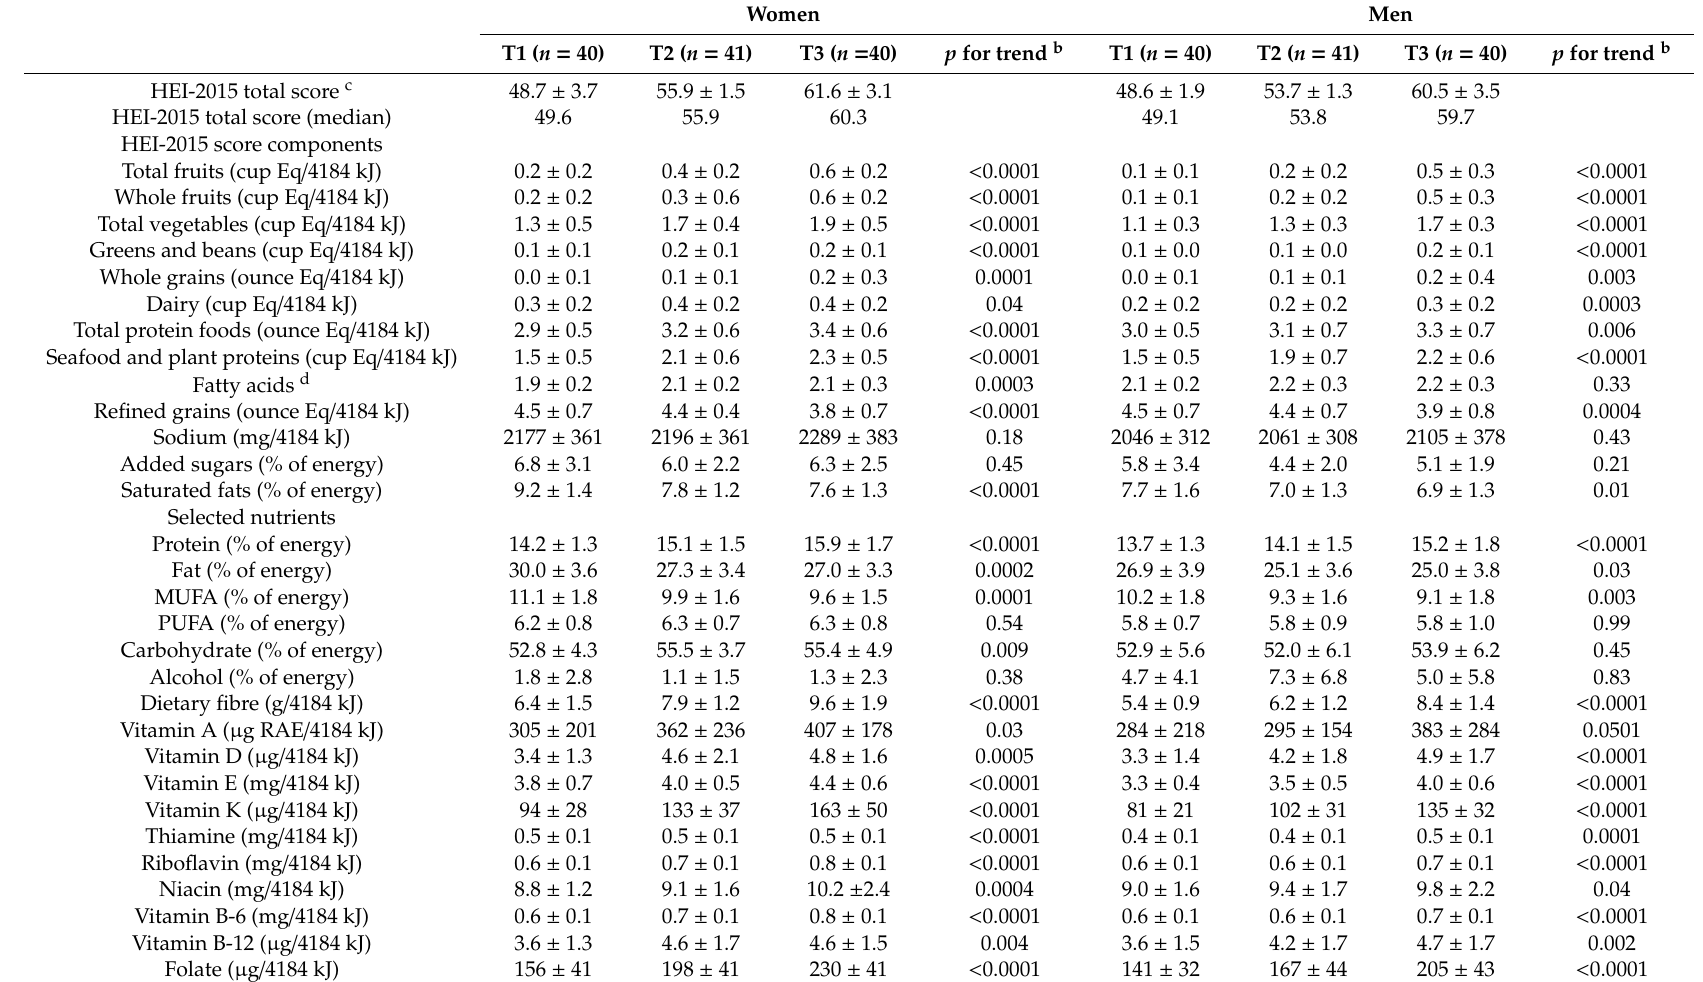
Table 4. Dietary intake according to tertile category of the HEI-2015 total score estimated from a 16-day weighed dietary record in Japanese women and men a .